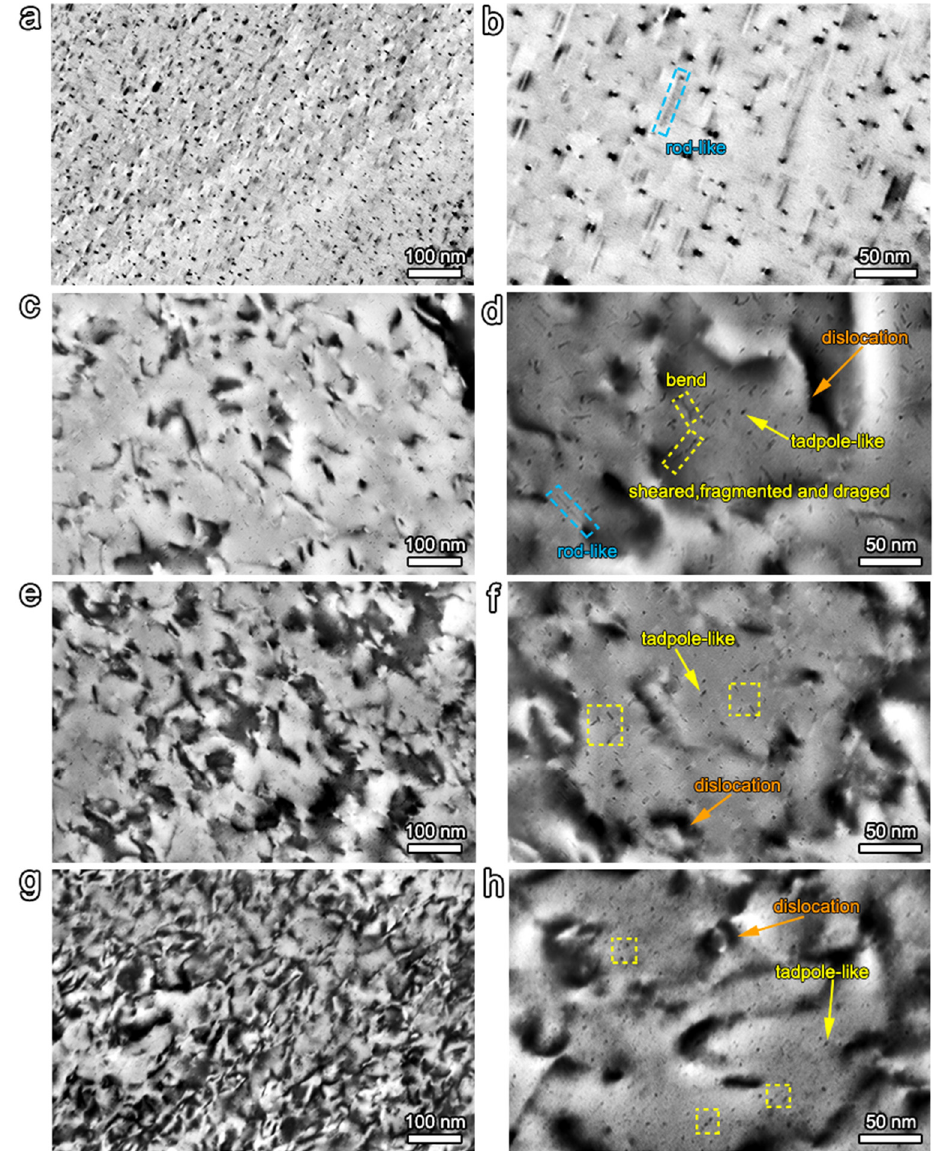
Figure 3. Bright-field TEM images of the initial samples ( a ) and deformed sample at area reduction ratio of 19% ( c ), 58% ( e ) and 91% ( g ), and their corresponding enlarged drawings ( b , d , f , h ).